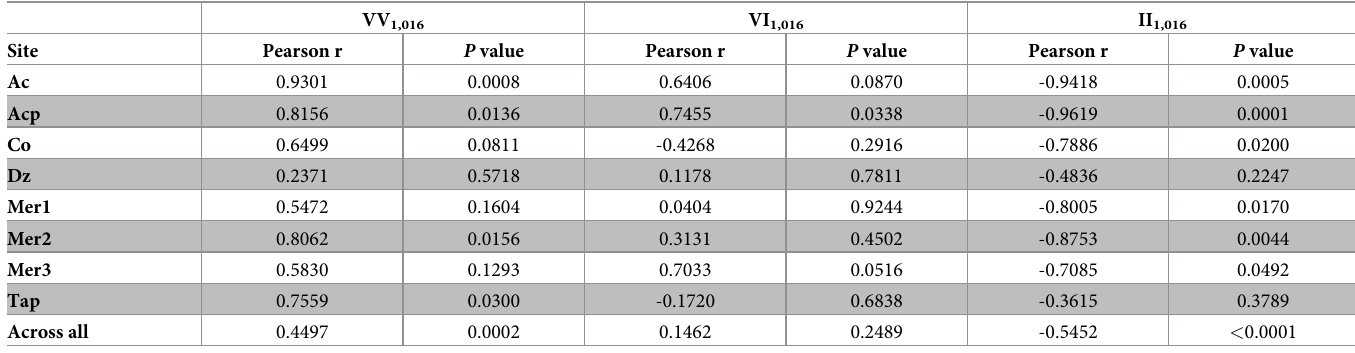
Table 2. Pearson’s correlation coefficient between the genotypes at locus V1,016I and generations in the absence of insecticides. Susceptible-homozygote = VV 1,016 , heterozygote = VI 1,016 , and resistant-homozygote = II 1,016